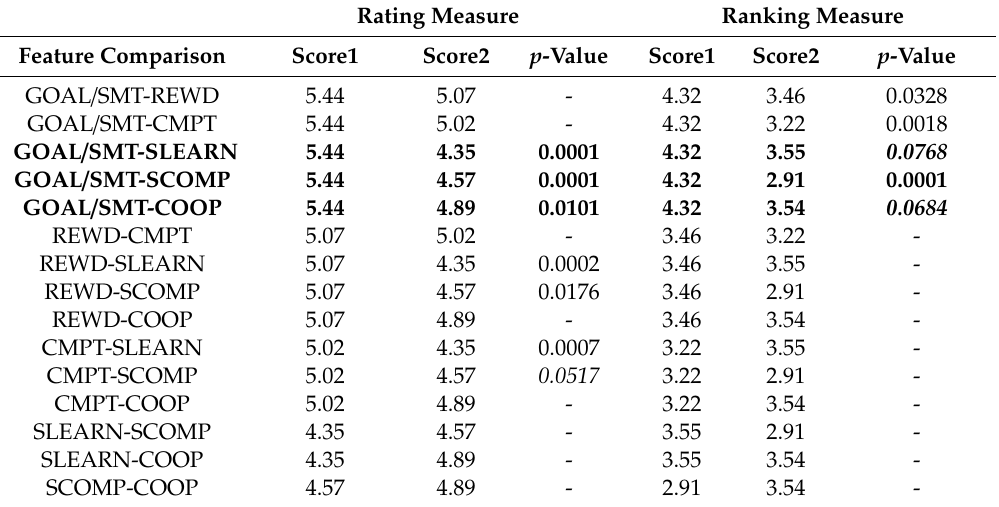
Table 5. Posthoc pairwise comparisons of persuasive features for the collectivist population sample. “-” means there is no significant di ff erence between each pair of features; bold values indicate the result of pairwise comparison is in the same direction regardless of measure and culture; italicized values indicate marginally significant comparisons; REWD = Reward, GOAL / SMT = Goal-Setting / Self-Monitoring, CMPT = Competition, SCOMP = Social Comparison, SLEARN = Social Learning, COOP = Cooperation. Rating Measure Ranking Measure Feature